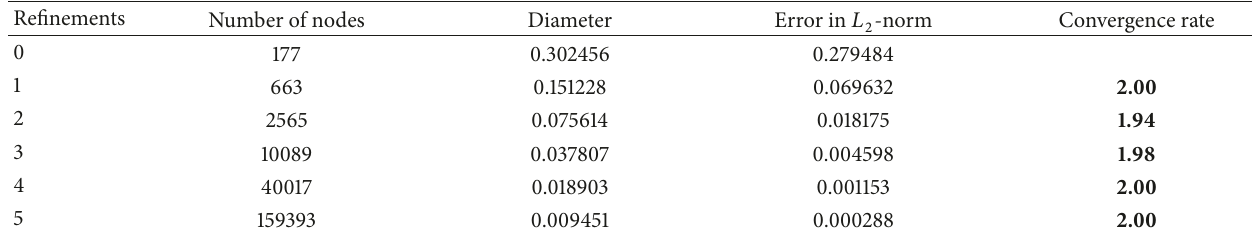
Table 2: Order of convergence in 𝐿 2 -norm for homogeneous Dirichlet BC.